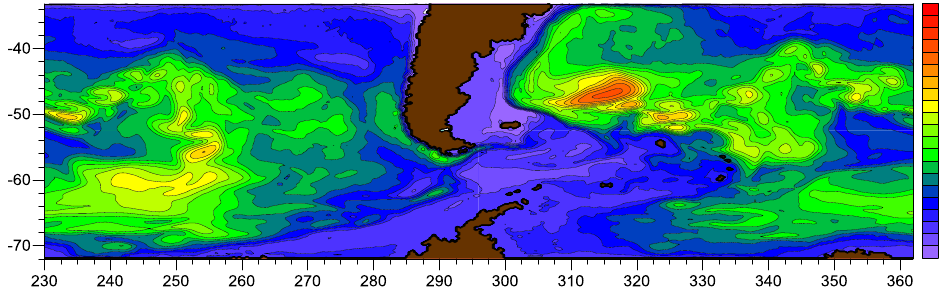
frequency signal ˜ η : blue line) at P1 during the reference in- terval; the SSH maps in the AB corresponding to the two se- quences of six instants denoted by the green and red dots